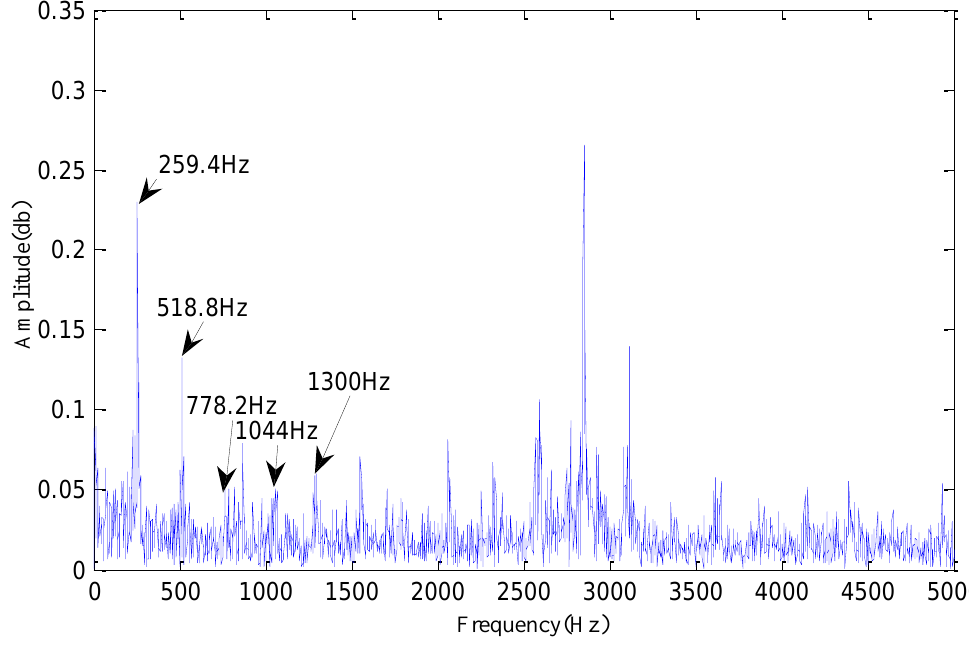
Figure 8. AE partial enlarged view of frequency spectra after redundant second generation wavelet denoising and Hilbert